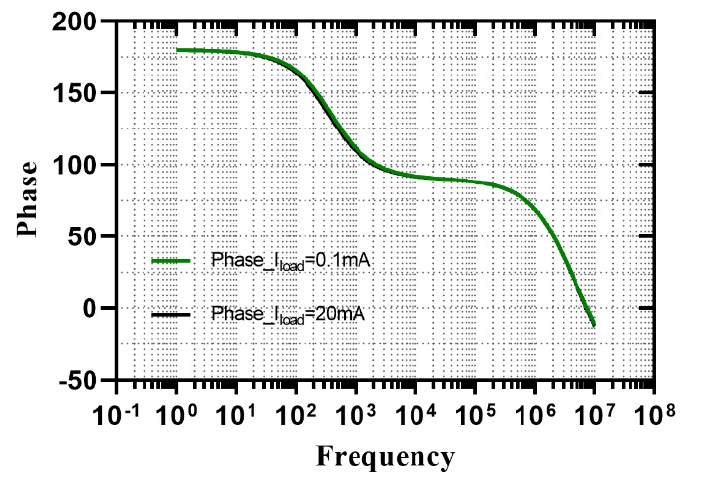
Figure 9. Frequency response at different I OUT values.